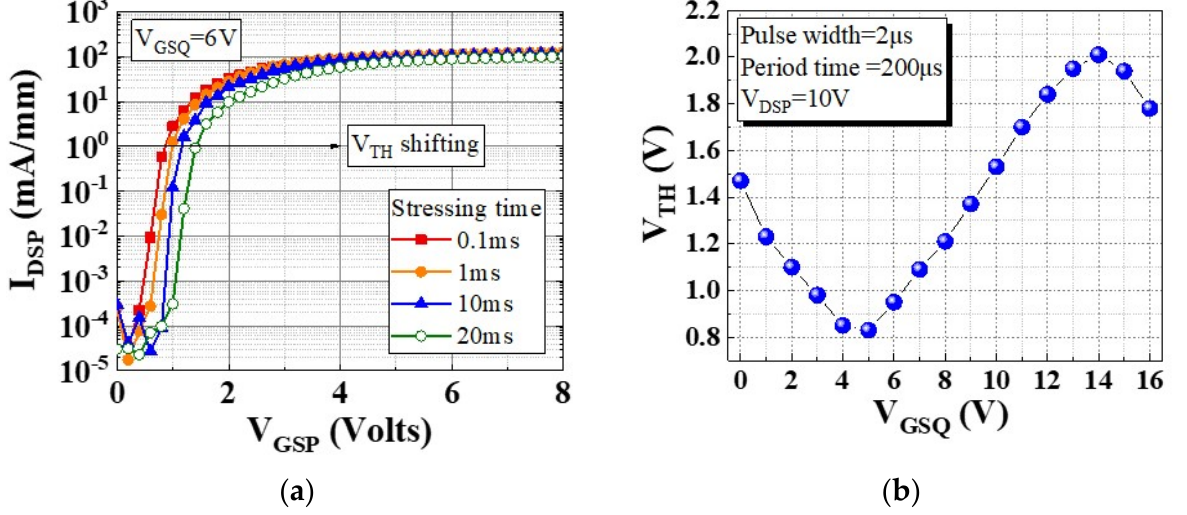
Figure 5. ( a ) Dynamic transfer characteristics measured for various stress durations, and ( b ) V TH shifting for different V GSQ .